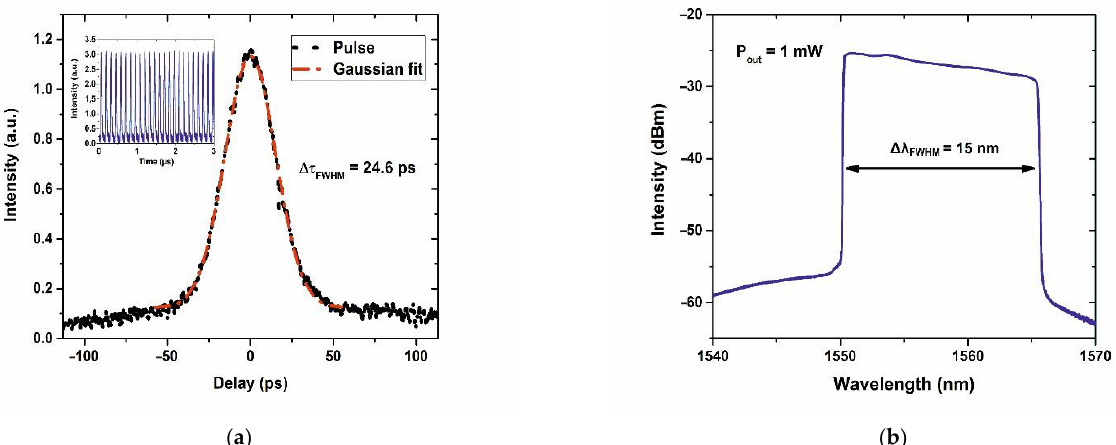
Figure 2. ( a ) An USP intensity autocorrelation and Gaussian fitting with a typical pulse train (inset); ( b ) Chirped-pulse spectrum before amplification of the all-fiber EDF USP ring laser with C:BNNTs.